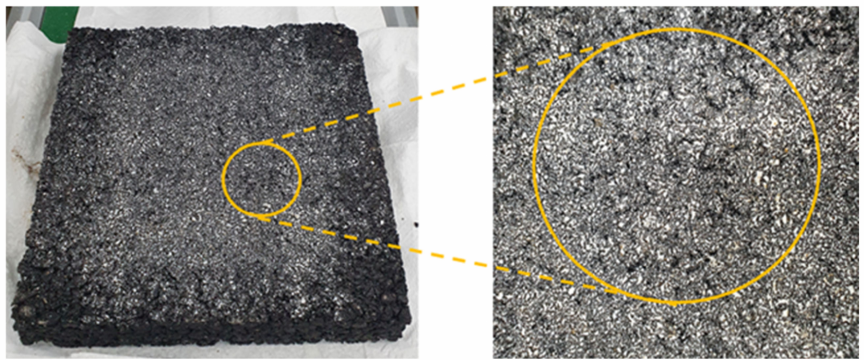
Figure 3. Images of the surface treated